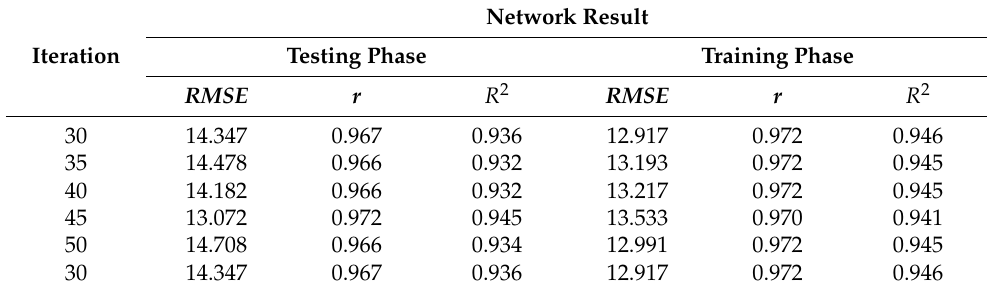
Table 9. The calculated accuracy criteria for the performance of the implemented models (Population = 125).